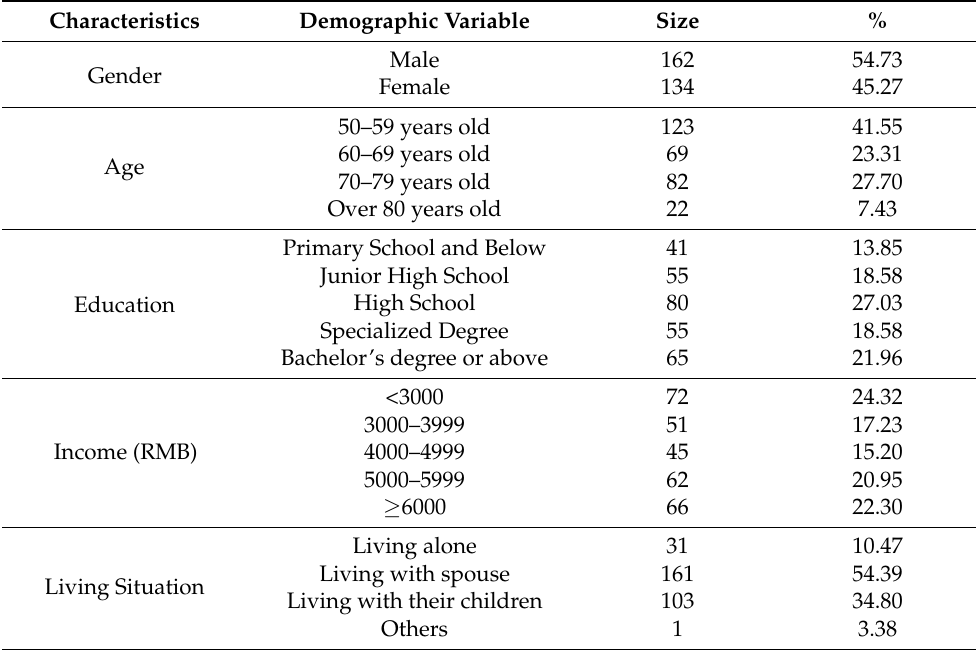
Table 2. Basic information of the survey